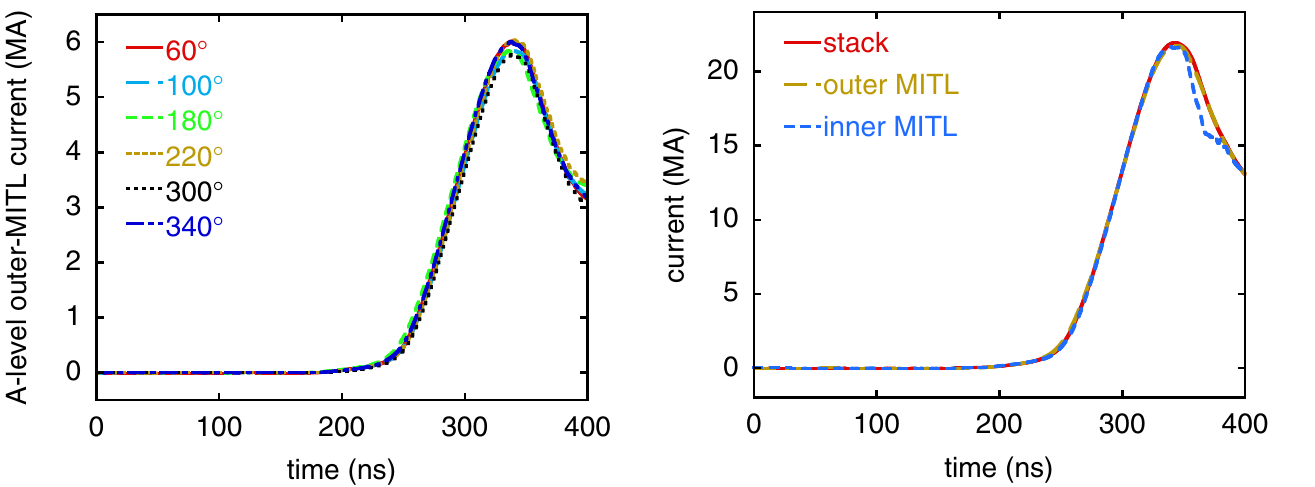
FIG. 14. (Color) Measurements on Z -shot 1548 of the A-level MITL current at 6 azimuthal locations.